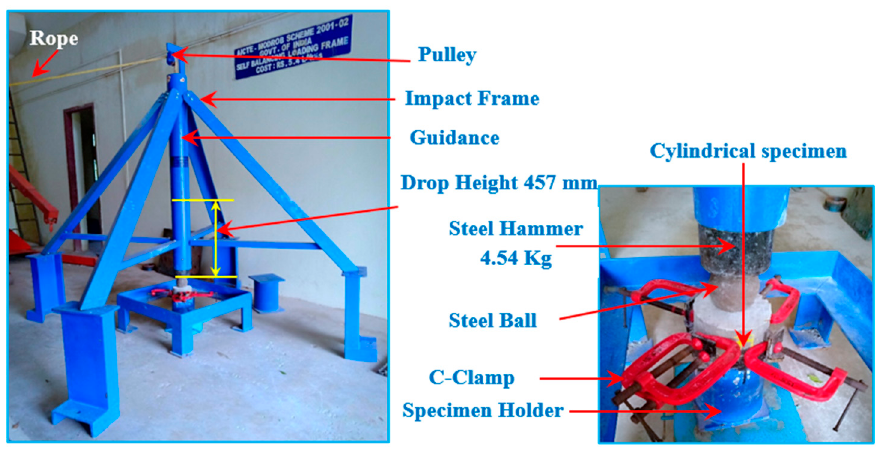
Figure 7. Impact test setup.